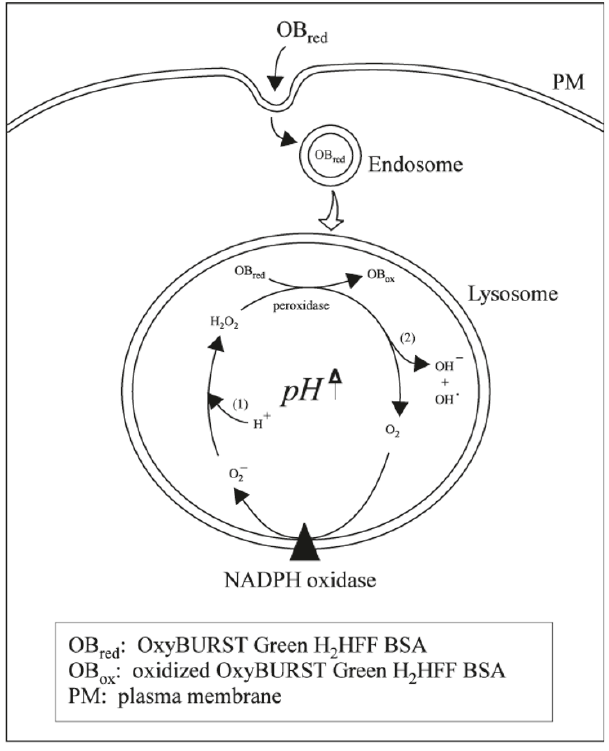
Figure 11 Proposed mode of OxyBURST Green H 2 HFF BSA oxidation and the regulation of pH in lysosomes upon stimulation with phorbol